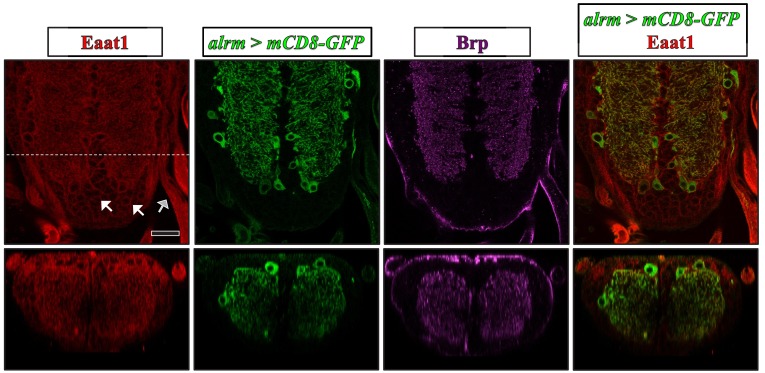
Expression pattern of Eaat1 in the larval VNC.Representative confocal images of third instar larval VNCs expressing UAS-mCD8-GFP driven with alrm-GAL4 (an astrocyte-like glia-specific GAL4) and co-stained with α-Eaat1 (red), α-GFP (green), and α-Brp (nc82, magenta). Astrocyte-like glia are enriched for Eaat1 expression. Moreover, Eaat1 was found in cortex glia (white arrows) and in ensheathing glia (gray arrows). Bottom panels show cross-sectional images reflecting the dotted white line. Scale bar: 20 μm.